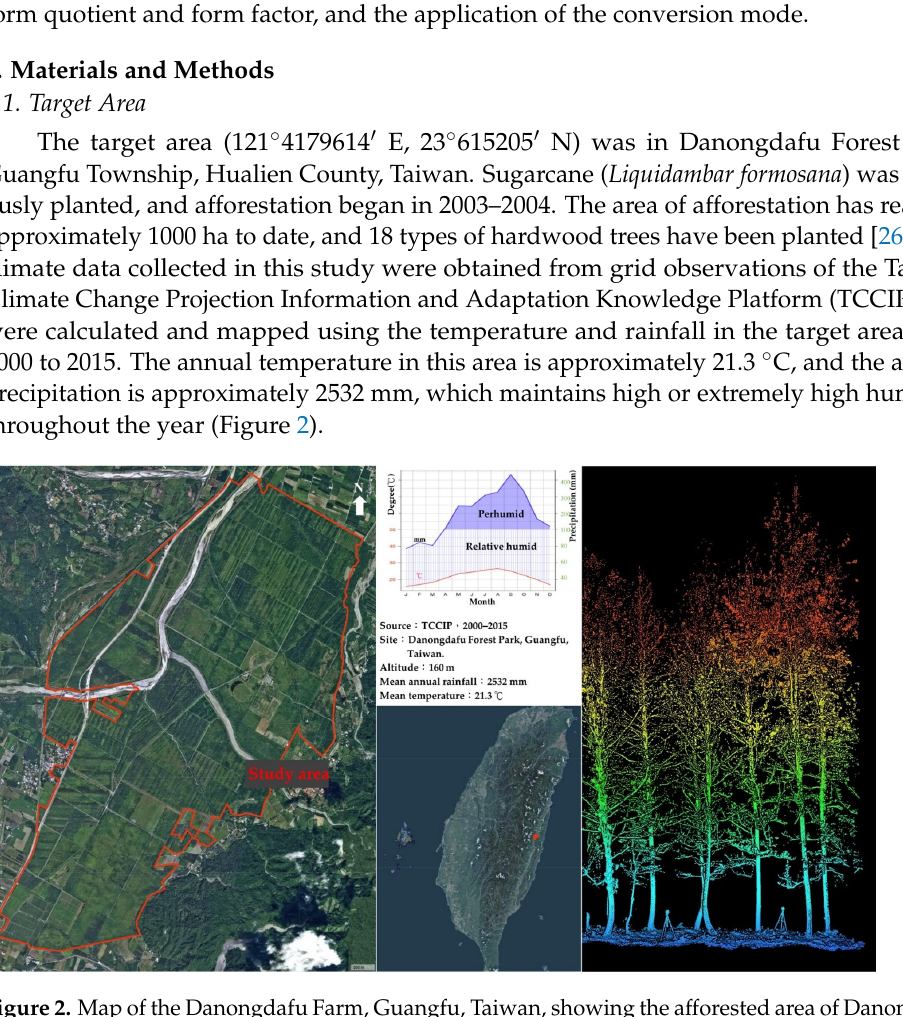
Figure 2. Map of the Danongdafu Farm, Guangfu, Taiwan, showing the afforested area of Danongdafu Forest Park, the climograph, and TLS image. TLS, terrestrial laser